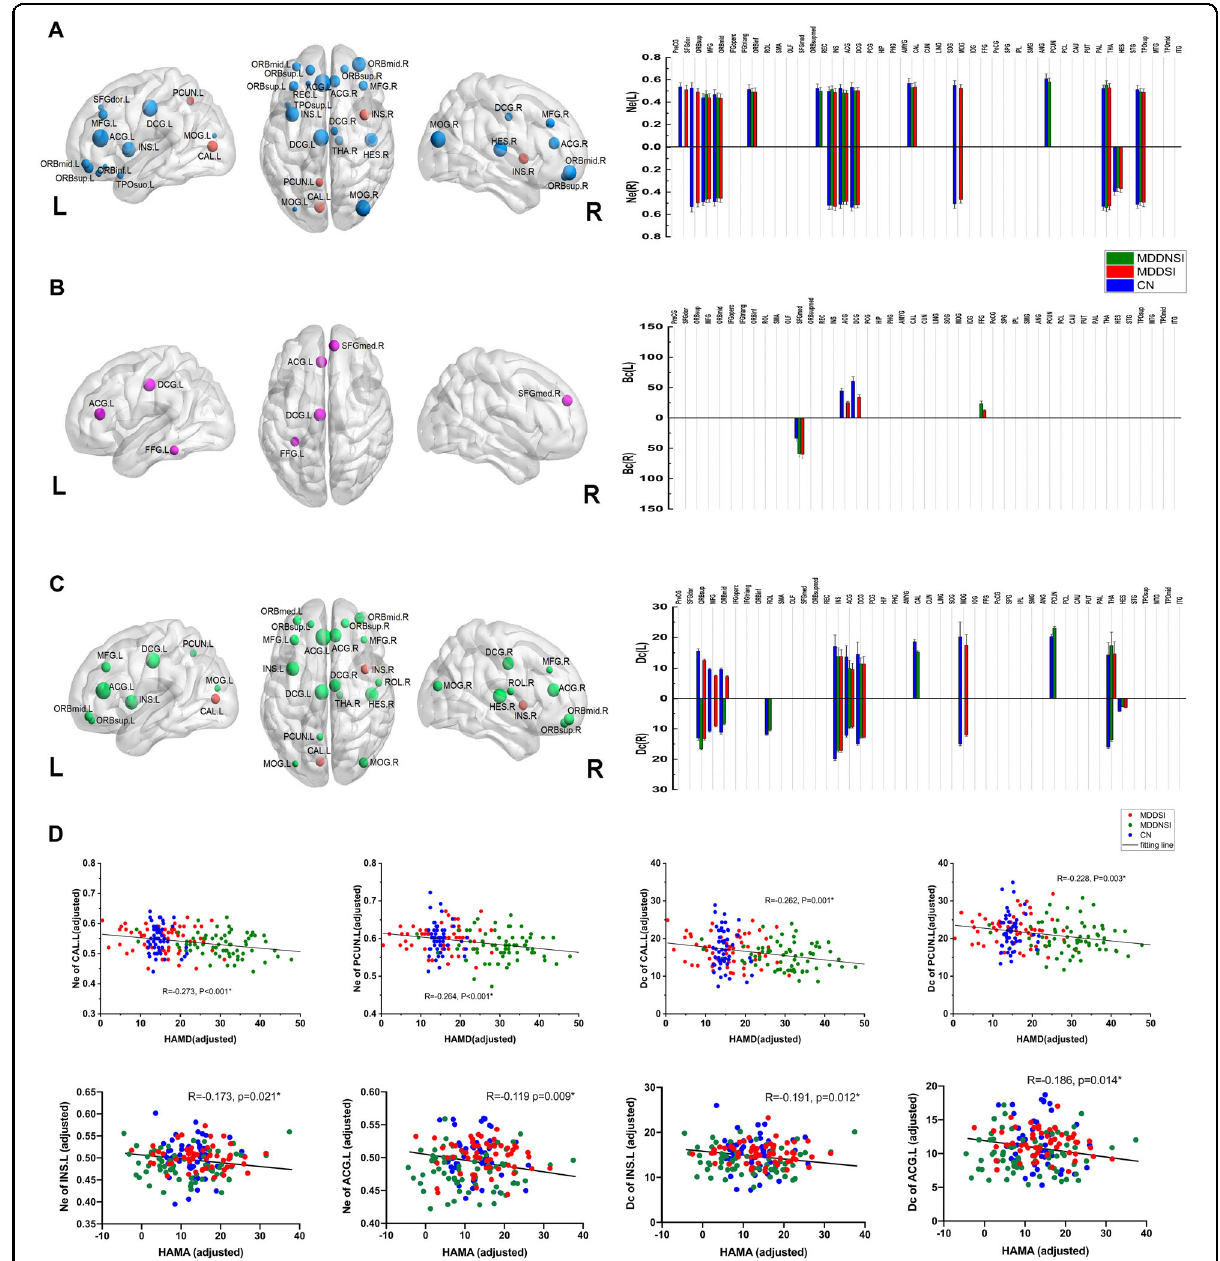
Fig. 2 Group-level comparison of nodal properties and behavioral signi fi cance. The distribution of the three groups of node property differences (front, A : Ne property; B : Bc property; C : Dc property) and the corresponding nodal values of the left and right hemispheres after the post- hoc analyses (back). The size of the node represents the F value obtained by ANOVA analysis among the three groups. The red node indicates the hub node, and the red asterisk (see B ) indicates a signi fi cant difference between MDDSI and MDDNSI ( P = 0.0004). These nodes are corrected by Bonferroni correction with a signi fi cant different P < 0.0005 (0.05/90). The strength of all types of properties is calculated as 20%. D The correlation diagram shows the relationship between the different hub node properties (Ne, Bc, Dc) and the severity of depression. The fi tted value represents the adjusted value after removing the covariates of age, gender, group, and years of education. CN, cognitively normal; MDDSI, major depression disorder with suicidal ideation; MDDNSI, major depression disorder with non-suicidal ideation. Ne, nodal ef fi ciency; Bc, betweeness centrality; Dc, degree centrality. L. left; R, right; ACG.L, left anterior cingulate and paracingulate gyrus; INS.L, left